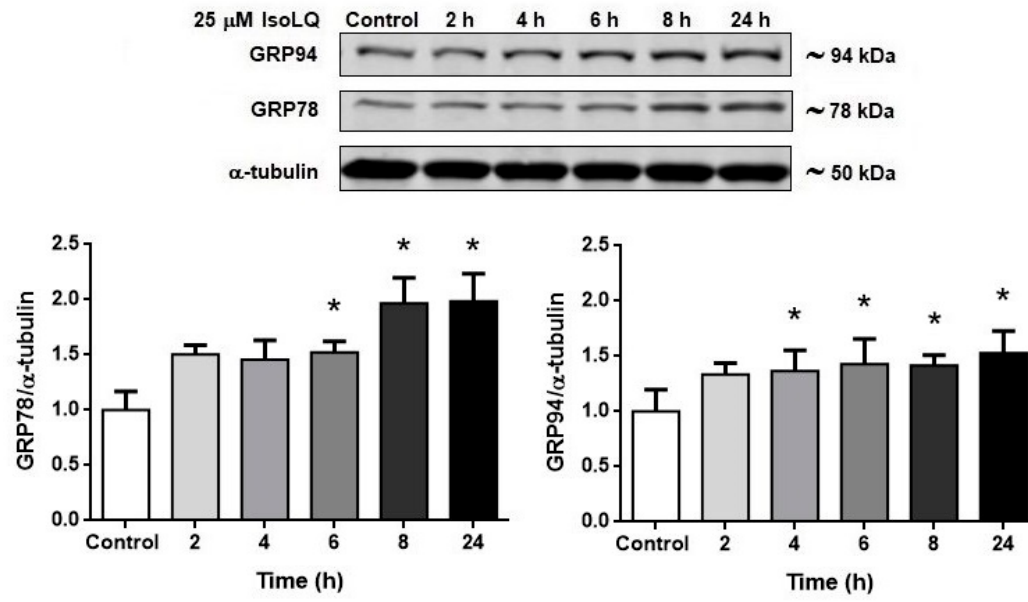
Figure 5. 25 µ M isoliquiritigenin (IsoLQ) induced endoplasmic reticulum (ER) stress in LLC-PK1 cells. Glucose-related protein 78 kDa (GRP78), glucose-related protein 94 kDa (GRP94). Data are mean ± SEM, n = 3–4. * p < 0.05 vs. control (without IsoLQ).